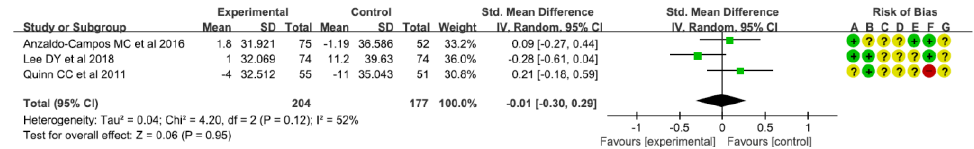
Figure 8. Forest plot for meta-analysis results on LDL-C [10,15,16].